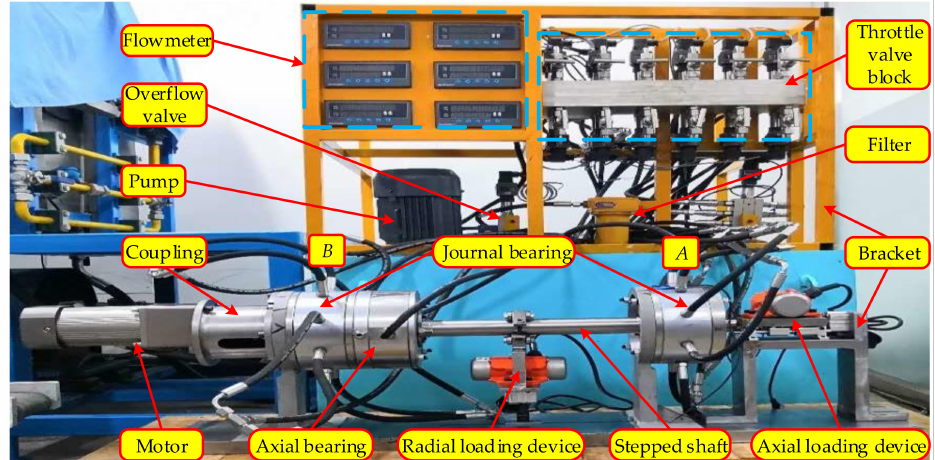
Figure 2. Magnetic liquid double suspension bearing (MLDSB) experimental